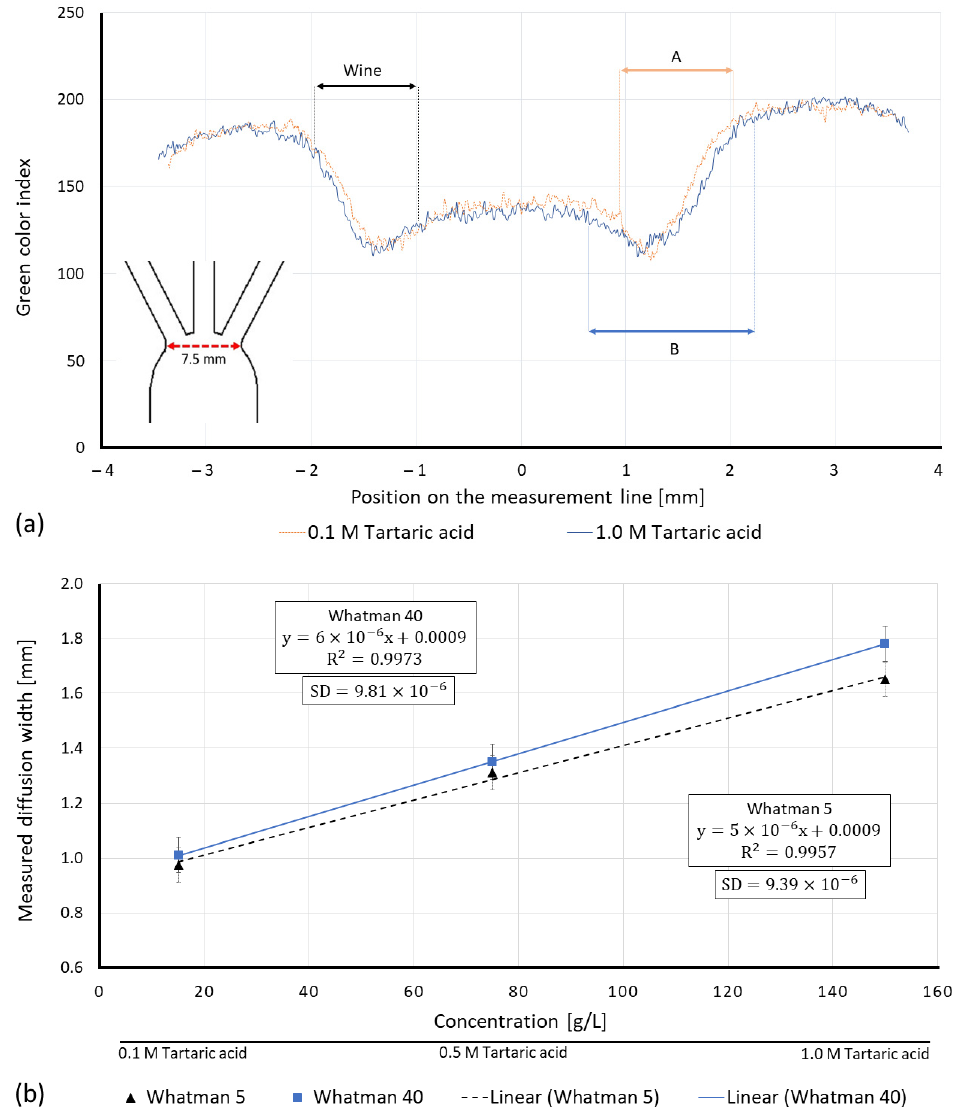
Figure 9. ( a ) Intensity of the green color channel at the measurement line of different tartaric acid concentrations at 120 s after the “Time zero” for the Whatman grade 40 paper strip. ( b ) Comparison between the measured diffusion width based on the changes in the intensity of the green channel and the calibration plots of the Whatman 40 (this work) and the Whatman 5 (previous work) [47] paper substrates. (SD = standard deviation).